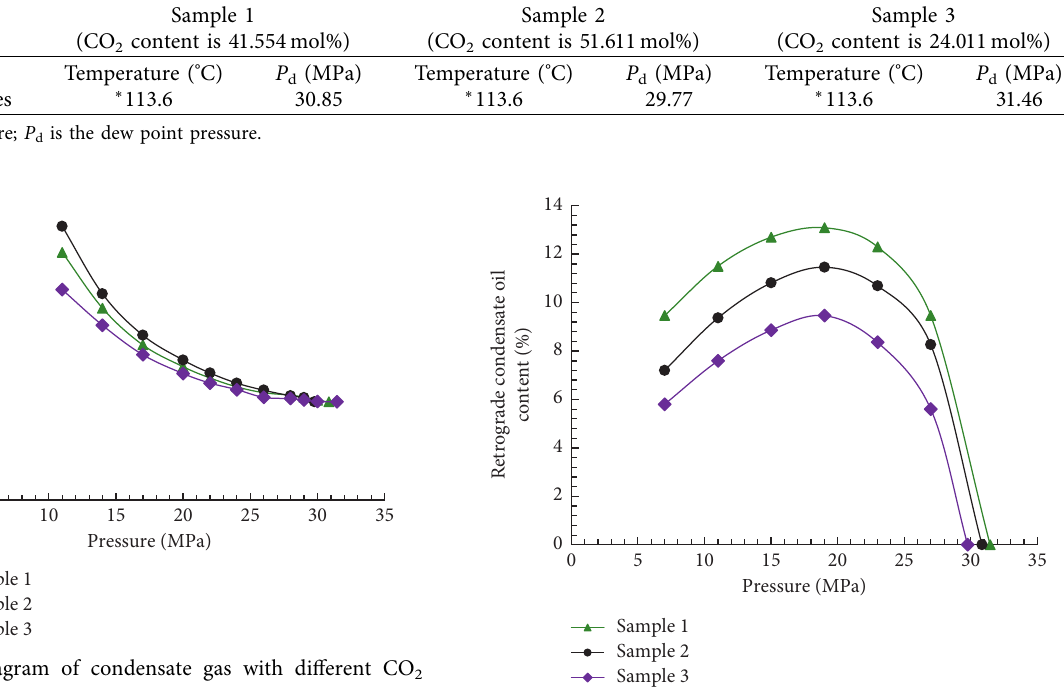
Table 4: Dew point pressure experimental results of condensate gas with different CO